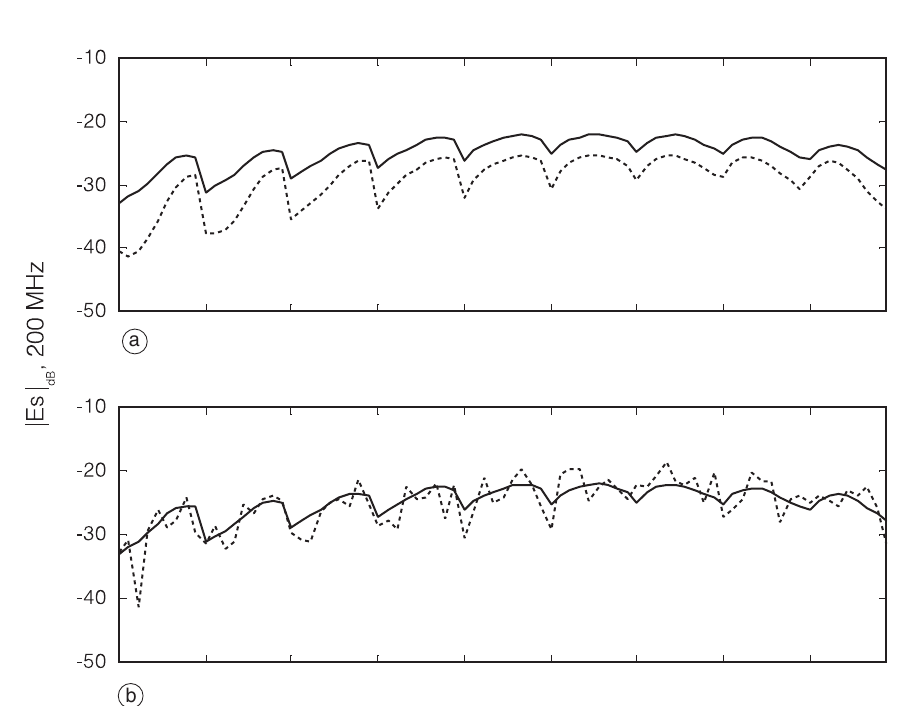
Fig. 4a,b. Case 1: a rectangular void. a) Comparison between actual scattered data (solid line) and data that would result according to the BA model (dotted line). b) Comparison between clean data (solid line) and data corrupted by noise with an SNR = 10 dB (dotted line). The plotted quantity is the modulus of the field at 200 MHz for each location of the transmitter and the receiver.